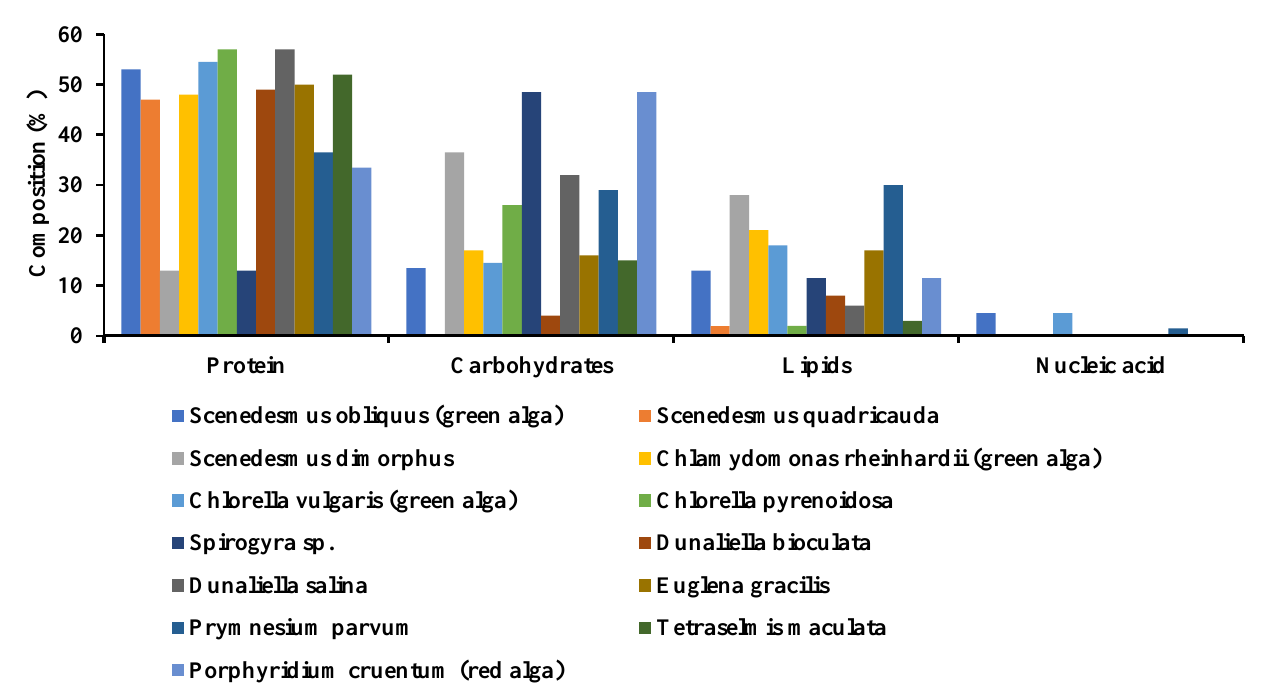
Figure 1. Organic composition of some selected microalgae.